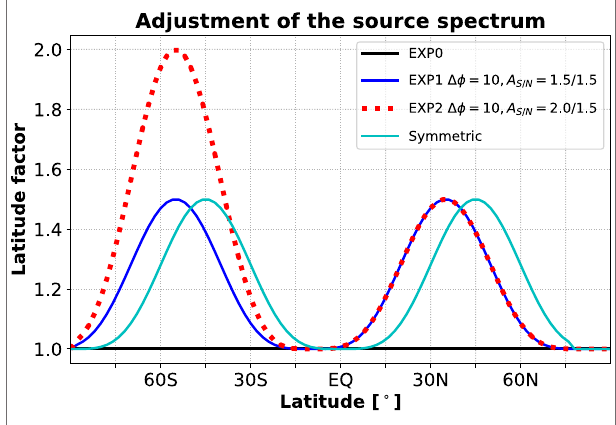
FIGURE 2 | Latitudinal factors used in the GW source spectrum for the maximum source momentum fl ux at 15 km, u ′ w ′ max , in simulations EXP0, EXP1, and EXP2, plotted in terms of how much the peak source momentum fl ux has been increased, somewhat mimicking the variations seen in SABER GW momentum fl ux observations. EXP0 (black) is the standard spectrum used in the parameterization. EXP1 (blue) assumes a sinusoidal variation of the maximum source fl ux with an amplitude of 50% increase with respect to EXP0 (hence the factor 1.5) and shifted by 10 degrees southward.